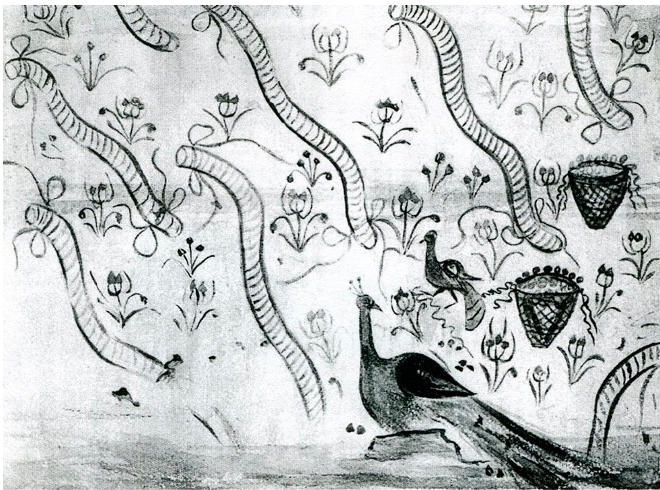
Figure 20. Sardis, Kâgirlik Tepe Tomb (Appendix A.7), painting of north wall. © Archaeological Exploration of Sardis/President and fellows of Harvard College.